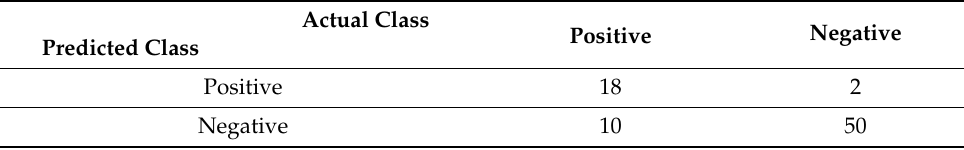
Table 10. Confusion matrix of failure mode prediction